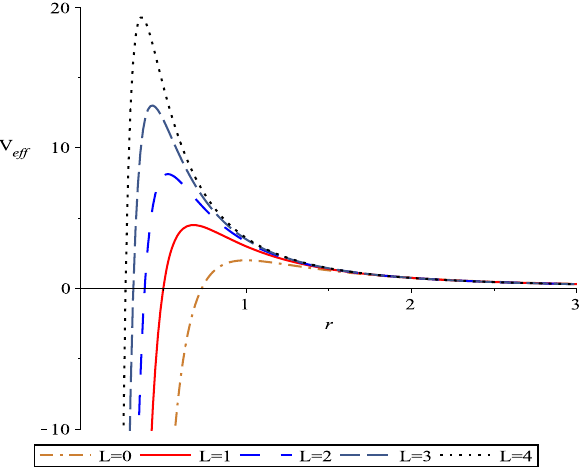
Fig. 1 Plotof V ef f versus r forbosonic(spin-0)particles.Thephysical parameters are chosen as follows M = m = 1 ,ω = 15 , a = 0 . 1, and λ = 2